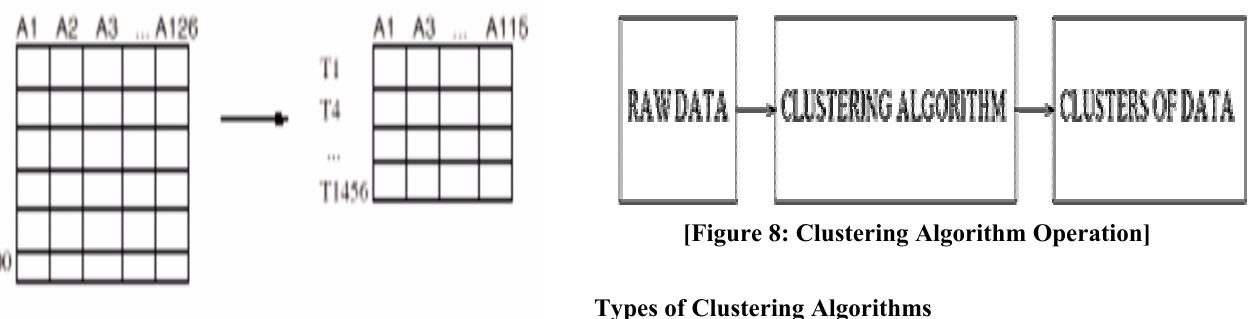
[Figure 4: Data Integration Process]